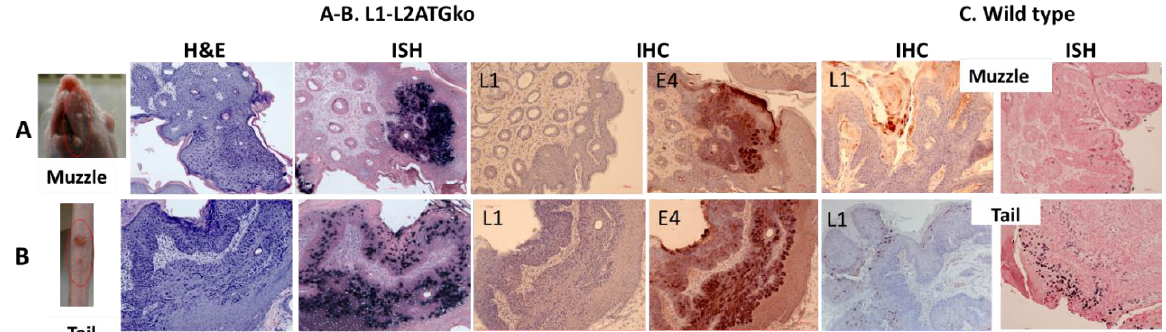
Figure 5. Five animals infected with the L1-L2ATGko developed cutaneous lesions in two repeat experiments. Three of five muzzle sites (Panel A ) grew visible tumors, and these tumors were multifocally and strongly DNA positive by in situ hybridization (20 × , ISH). No L1 staining was found by immunohistochemistry (IHC) with MPV.B9 (20 × ). E4 expression was intracytoplasmic and marked in these infected tissues (20 × ). Two of five tails also developed visible lesions (Panel B ). These lesions were positive for viral DNA and E4 expression but lacked L1 expression (20×). L1 expression was strongly positive in the upper epidermis as detected by IHC using MPV.B9 and ISH from wild-type MmuPV1 infected muzzle and tail tissues ( C , 20×).